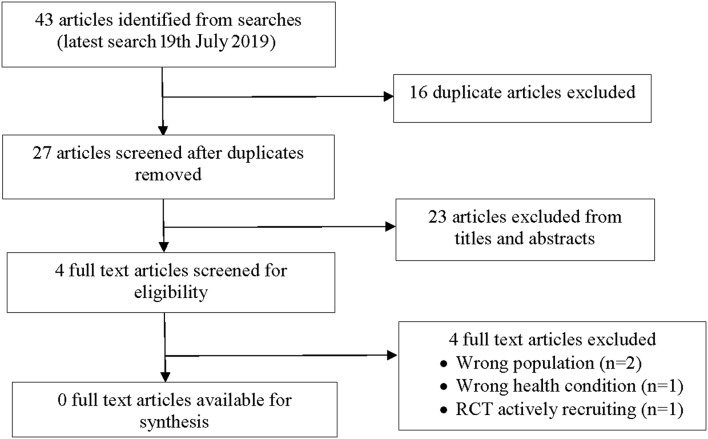
Study flow diagram.